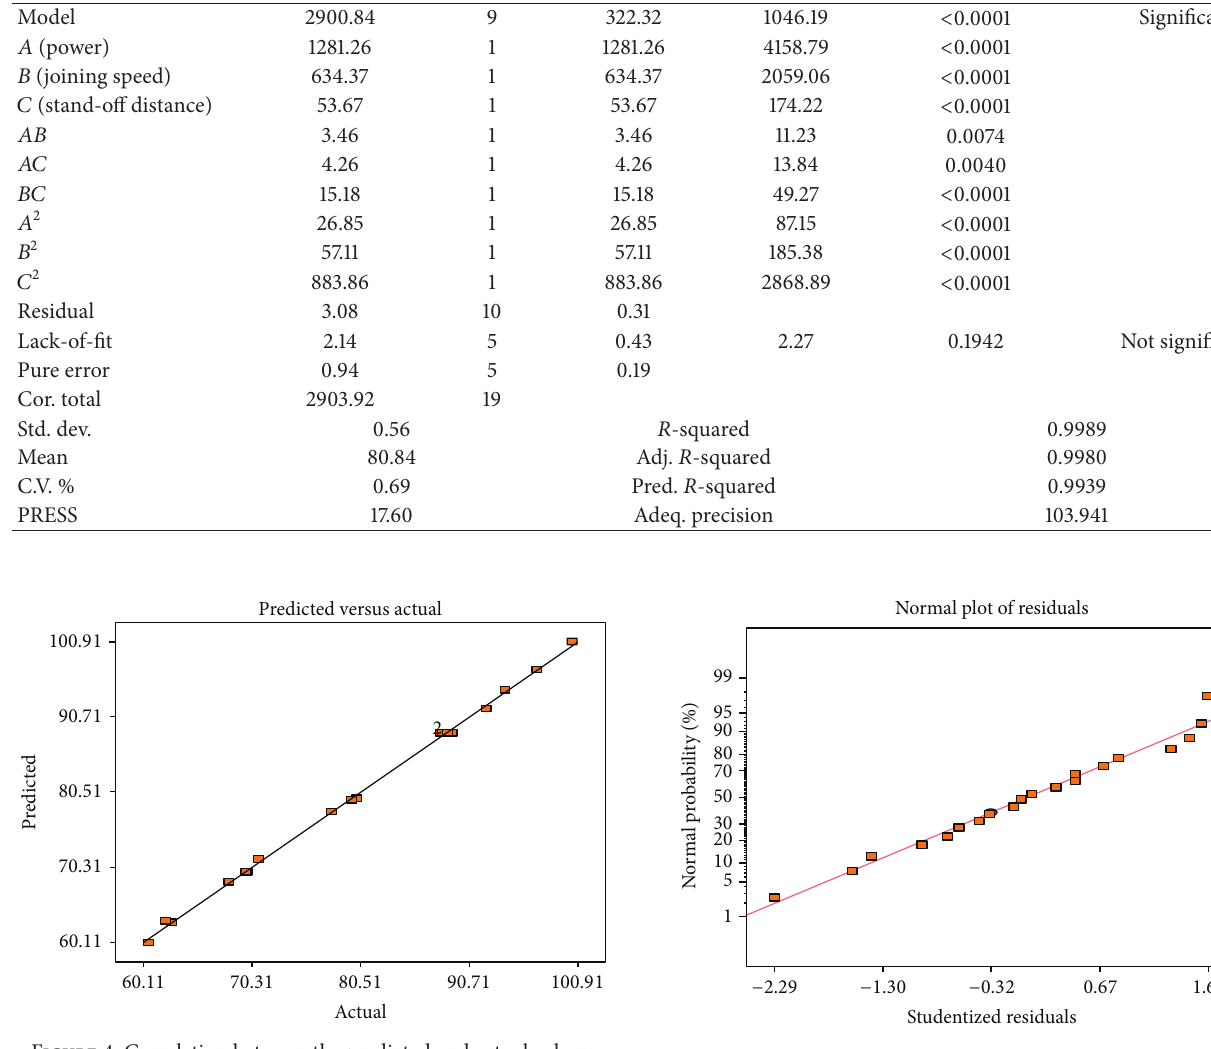
Figure 4: Correlation between the predicted and actual values. Figure 5: Normal probabilities of